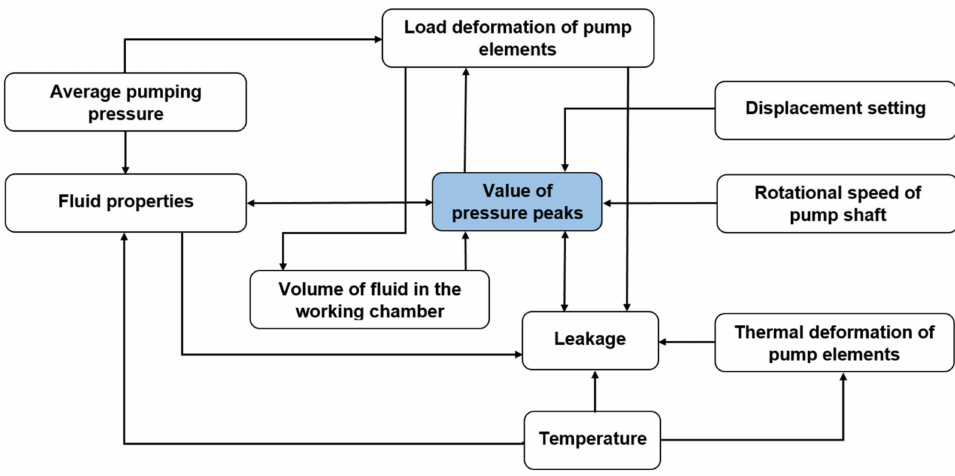
Figure 6. Factors affecting the value of the pressure peaks in the PWK